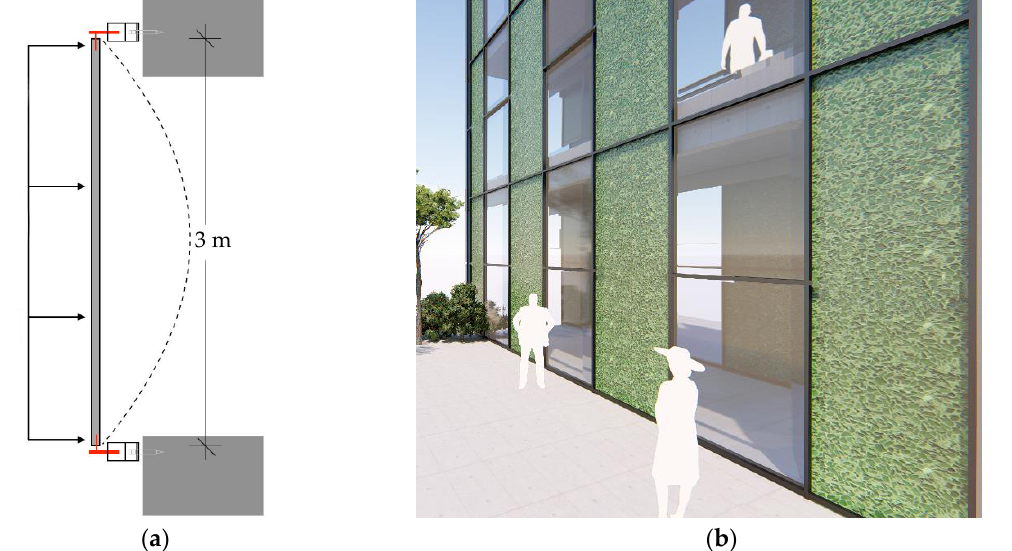
Figure 1. Possible applications. ( a ) Wind distributed loads along the 3m height; ( b ) Ventilated façade.